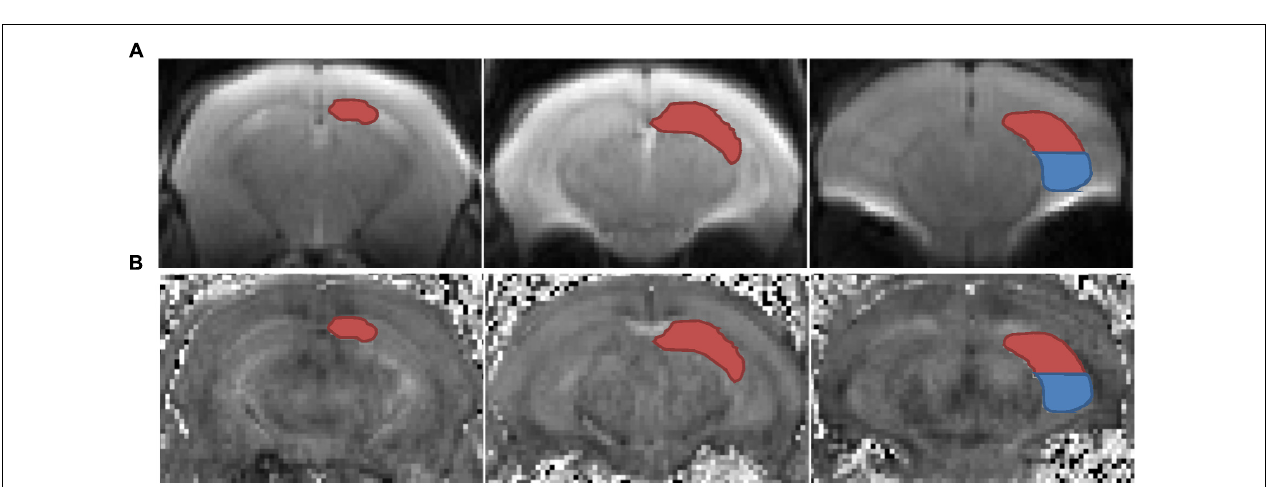
FIGURE 2 | Left dorsal (red) and ventral (blue) hippocampus were delineated in representative coronal B 0 maps (A) and FA maps (B) . ROIs, regions of